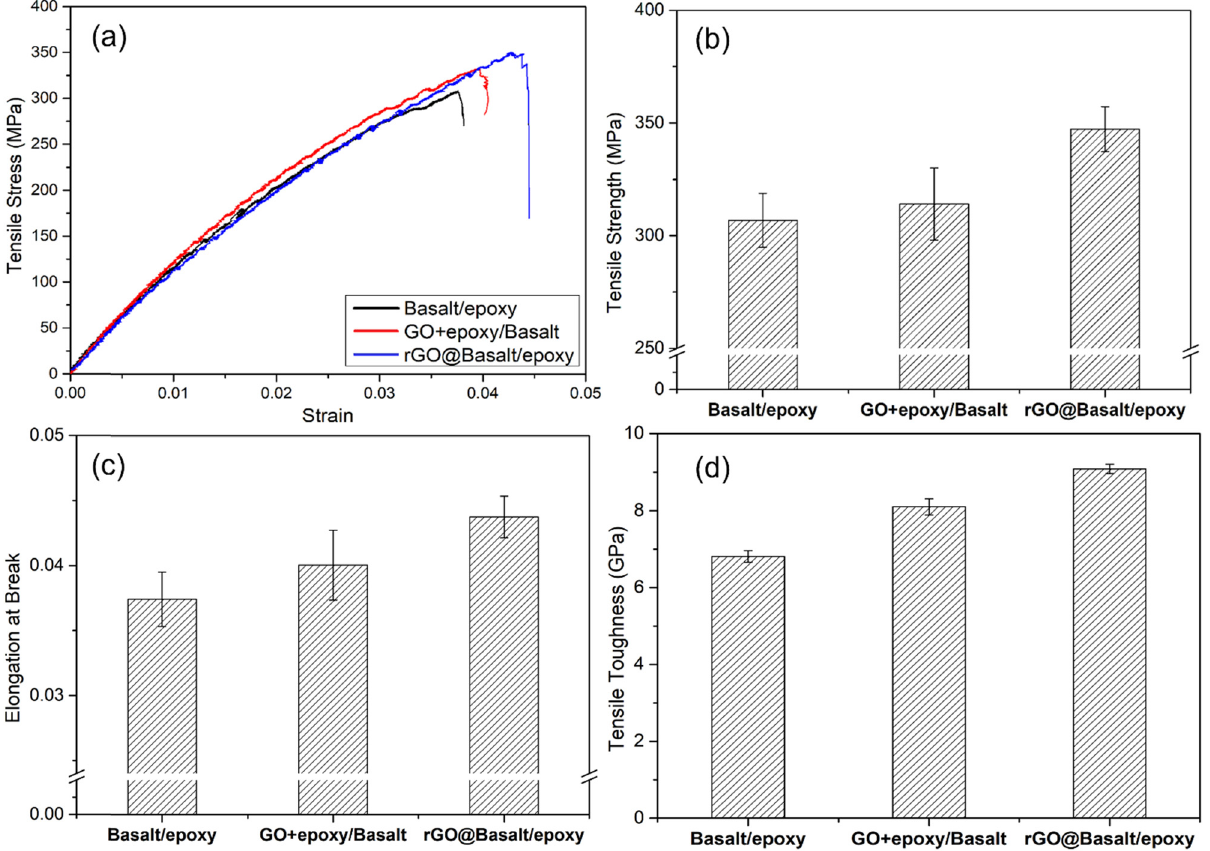
Figure 5: Mechanical test data of rGO@Basalt/epoxy, GO + epoxy/basalt and basalt/epoxy composites, where ( a ) strain – stress curve of tensile specimens, ( b ) tensile strength, ( c ) elongation at break, and ( d ) tensile toughness.